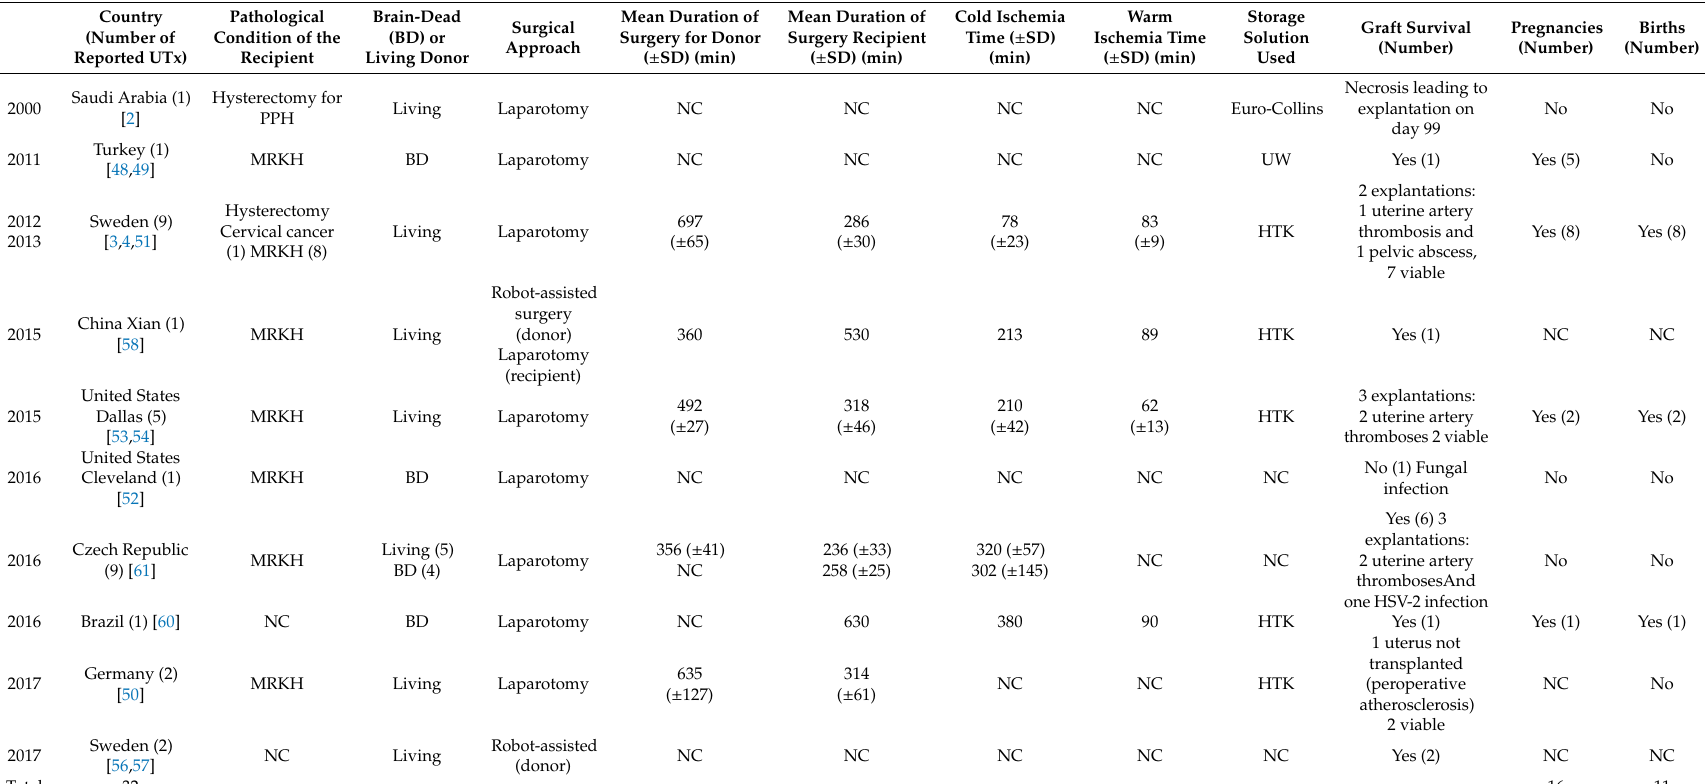
Table 2. Summary of UTx published, by type of donor, type of surgery and graft